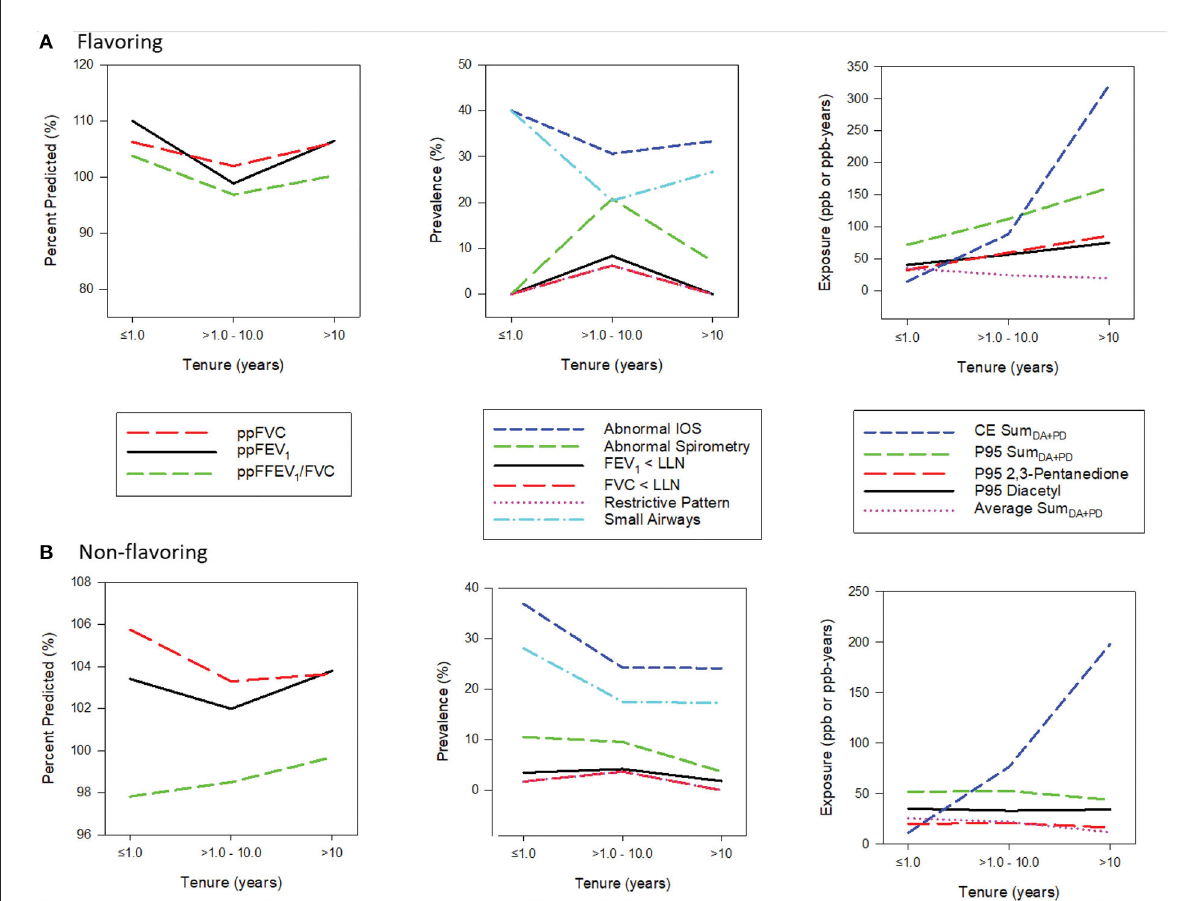
FIGURE2 (A,B) Panel plots of exposure and health characteristics by tenure stratified by